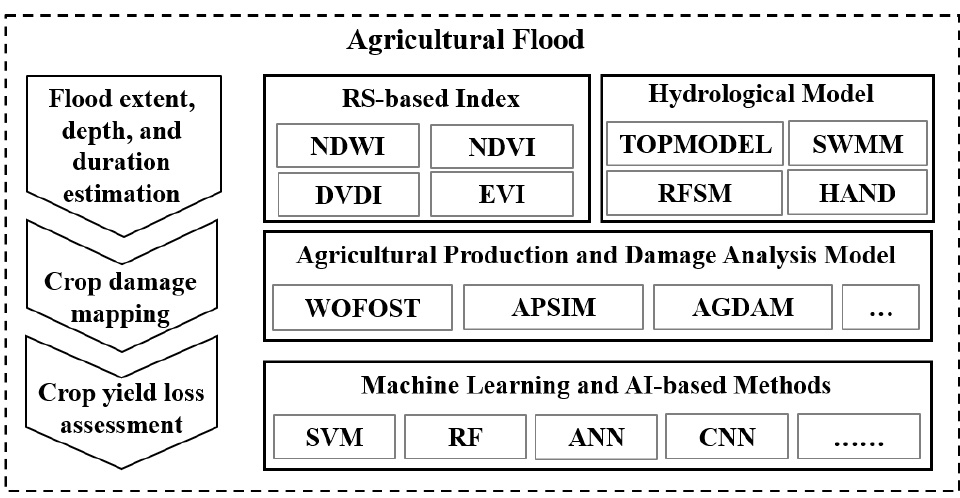
Figure 3. Agricultural flood disaster monitoring and assessment.